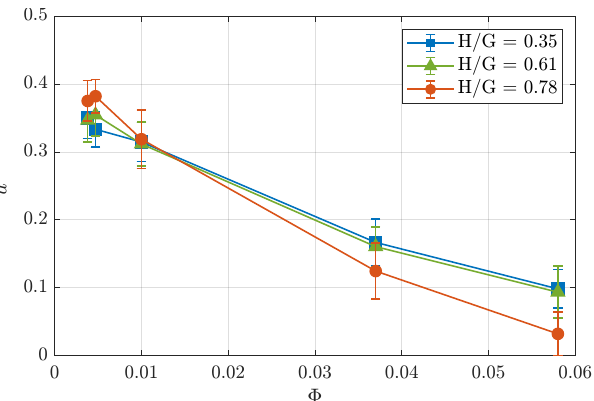
Figure 6. Maximum normalized longitudinal velocity ˆ u ∗ with respect to the foam liquid fraction for H / G = 0.35,0.6 and